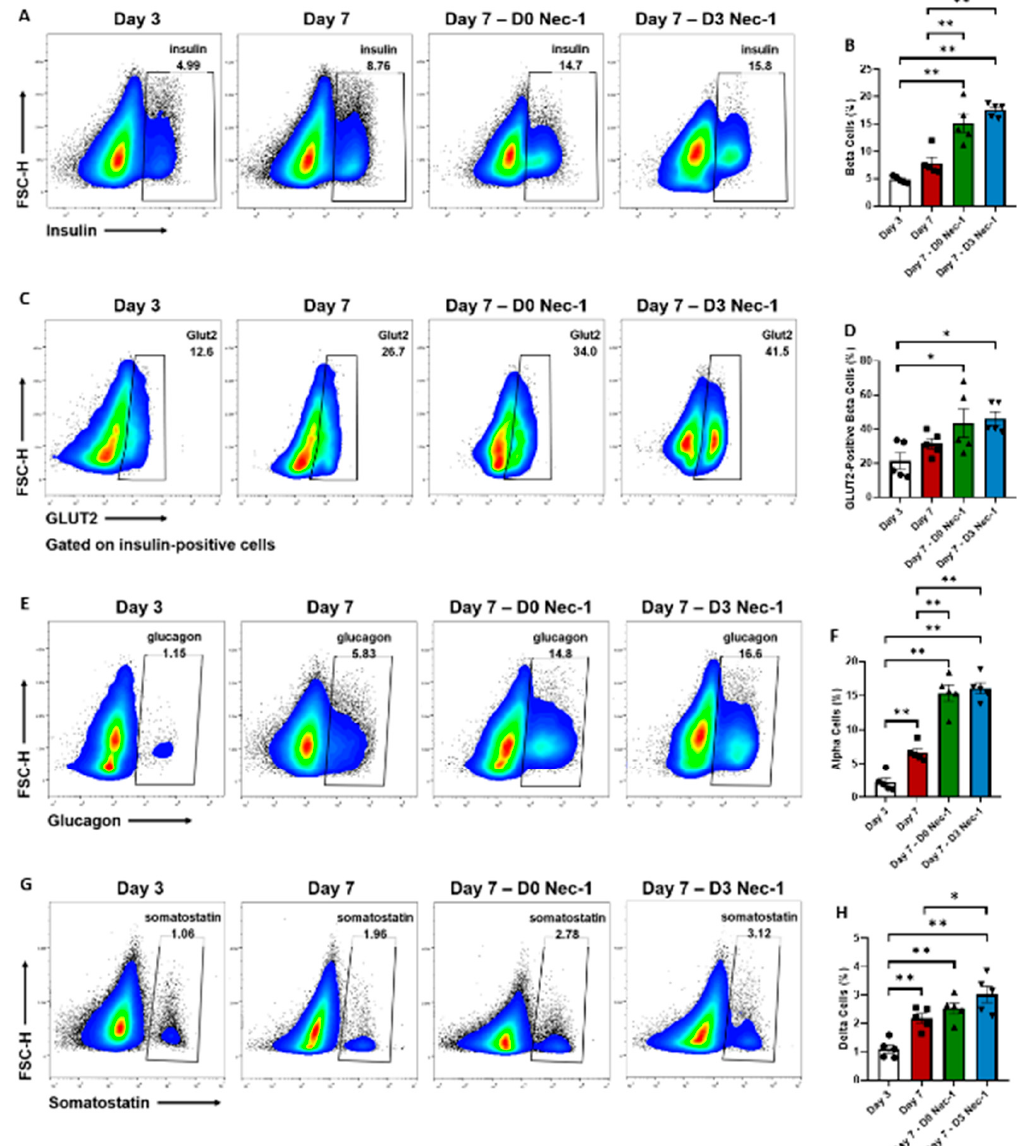
Figure 2. Flow cytometric analysis of cellular composition and GLUT2 expression in beta cells of PPIs on day 3 and 7 of tissue culture in control media or media supplemented with Nec-1 either immediately after islet isolation (D0 Nec-1) or on day 3 of tissue culture (D3 Nec-1). Islets were dissociated on day 3 and 7 of tissue culture using Accutase, stained with 7-AAD viability dye, anti-insulin, anti-glucagon, anti-somatostatin, and anti-GLUT2 antibodies, and analyzed by flow cytometry. ( A ) Representative flow cytometry plots of insulin staining of live islet cells on day 3 and 7 of tissue culture. ( B ) The percentage of insulin-positive beta cells on day 3 and 7 of tissue culture. ( C ) Representative flow cytometry plots of GLUT2 staining of live insulin-positive islet cells on day 3 and 7 of tissue culture. ( D ) The percentage of GLUT2-positive, insulin-positive beta cells on day 3 and 7 of tissue culture. ( E ) Representative flow cytometry plots of glucagon staining of live islet cells on day 3 and 7 of tissue culture. ( F ) The percentage of glucagon-positive alpha cells on day 3 and 7 of tissue culture. ( G ) Representative flow cytometry plots of somatostatin staining of live islet cells on day 3 and 7 of tissue culture. ( H ) The percentage of somatostatin-positive delta cells on day 3 and 7 of tissue culture. n = 5 for each group. * p < 0.05. ** p < 0.01. Individual data points for islets cultured in control media on day 3 (Day 3) or day 7 of tissue culture (Day 7) or in media supplemented with Nec-1 either immediately after islet isolation (D0 Nec-1) or on day 3 of tissue culture (D3 Nec-1) are shown within each bar graph as either circles, squares, triangles, or inverted triangles, respectively. Data expressed as mean ± SEM.